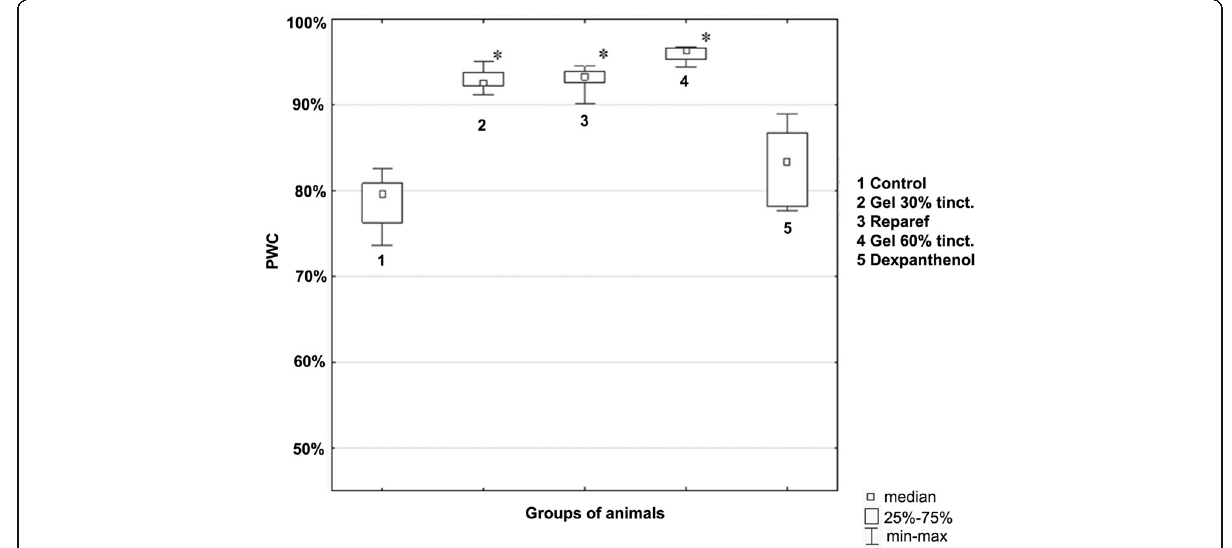
Fig. 3 Percentage of wound closure per day 13. * p < 0.05 vs control